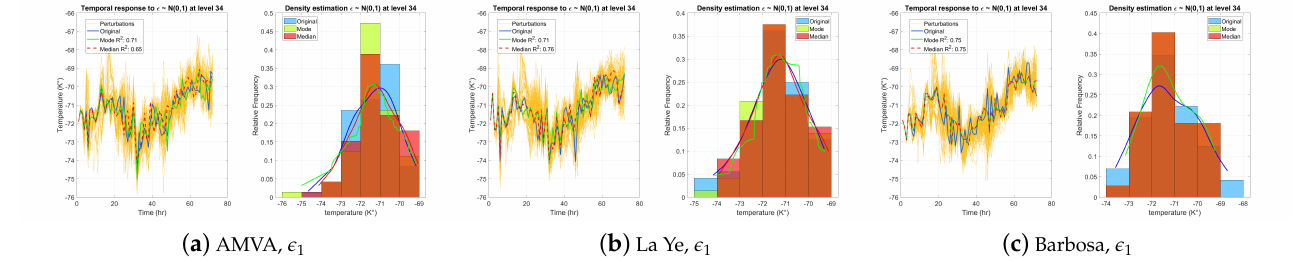
Figure 9. Histogram for samples drawn from distribution (cid:101) 1 , mode, median, and the respective estimated density. In addition, the temporal responses by temperature for the highest level in the output, R 2 , mode, and median for each evaluation location are visible. ( a ) Temporal response at AMVA station, histogram for samples drawn from (cid:101) 1 , mode, and median. ( b ) Temporal response at La Ye station, histogram for samples drawn from (cid:101) 1 , mode, and median. ( c ) Temporal response at Barbosa station, histogram for samples drawn from (cid:101) 1 , mode, and median. Different colors shows the interpolation between the different histograms.